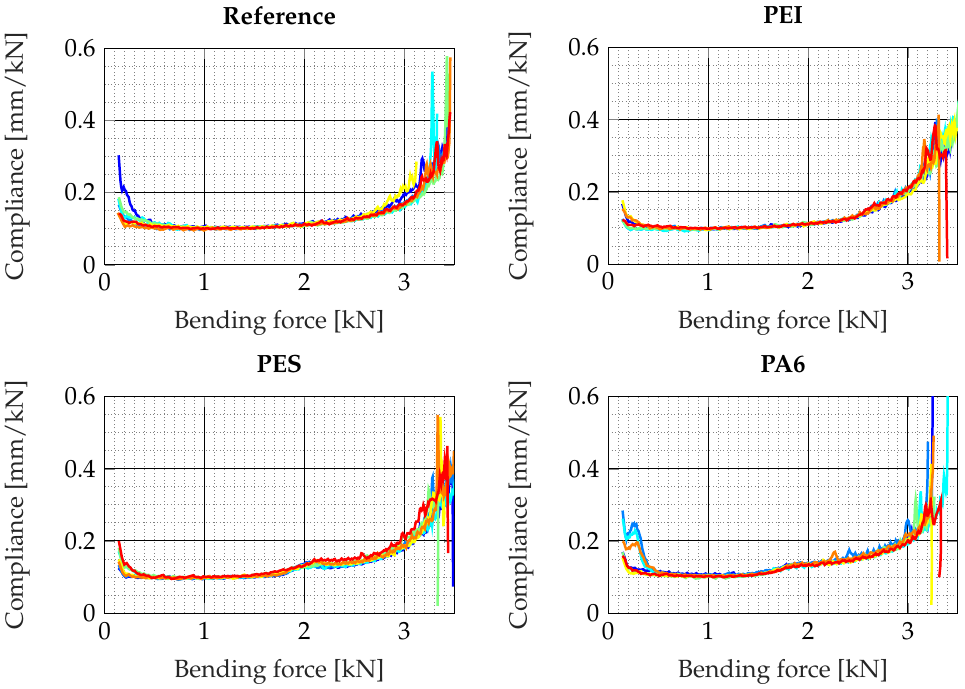
Figure 9. Influence of thermoplastic films on differential compliance in the interlaminar shear test. Every line shows the course of the compliance function of one single specimen.